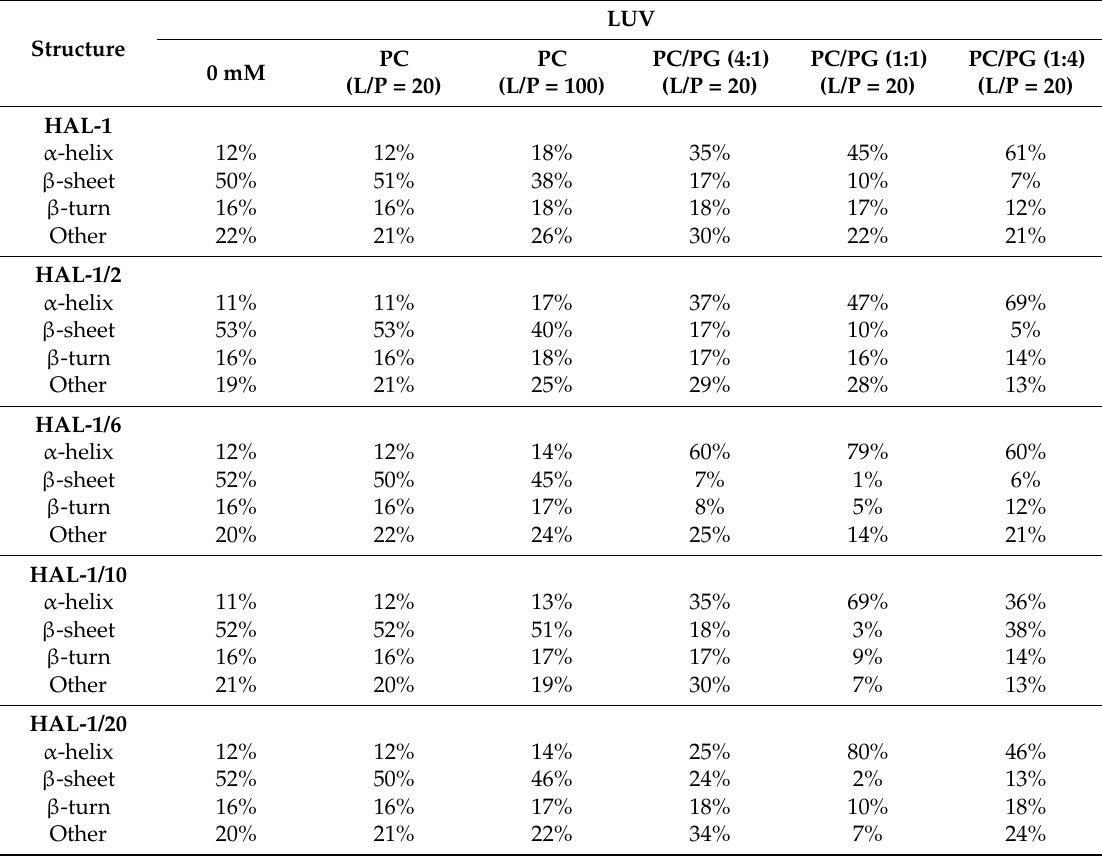
Table A3. Estimation of the secondary structure content calculated from ECD spectra using the CDPro package [62,73] for HAL-1 and its analogs in aqueous solution, and in the presence of